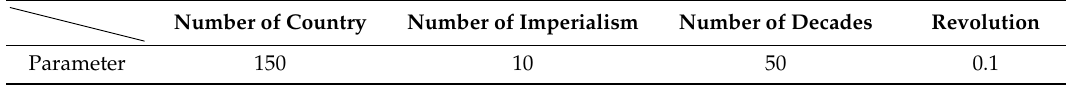
Table 5. Parameters of each imperialist competitive algorithm (ICA).